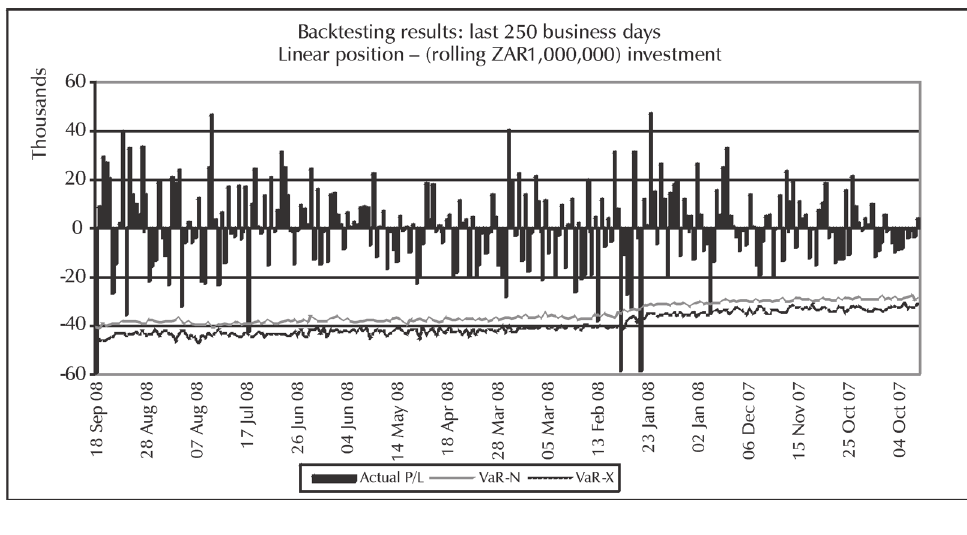
Backtesting results for short linear ZAR1m rolling investment